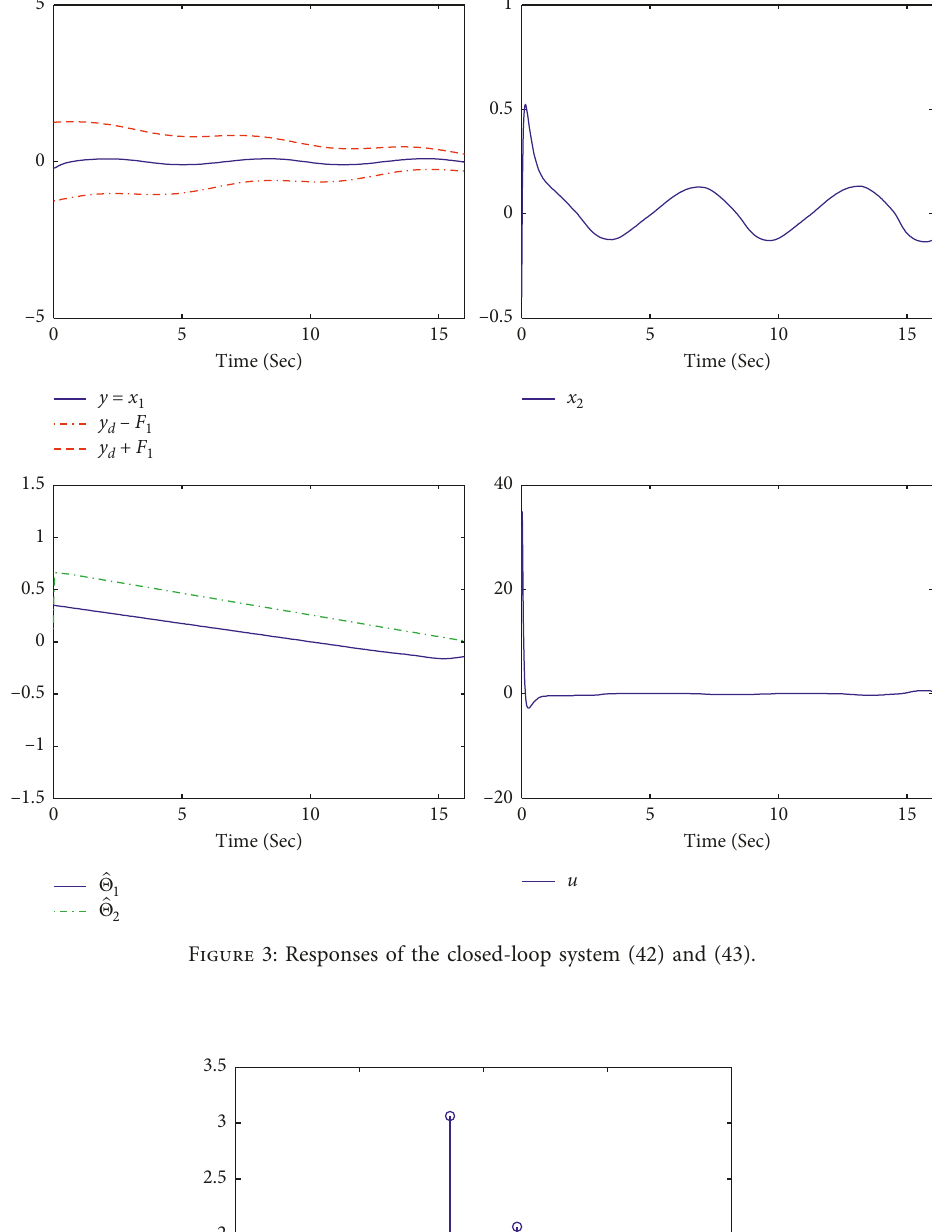
Figure 3: Responses of the closed-loop system (42) and (43).